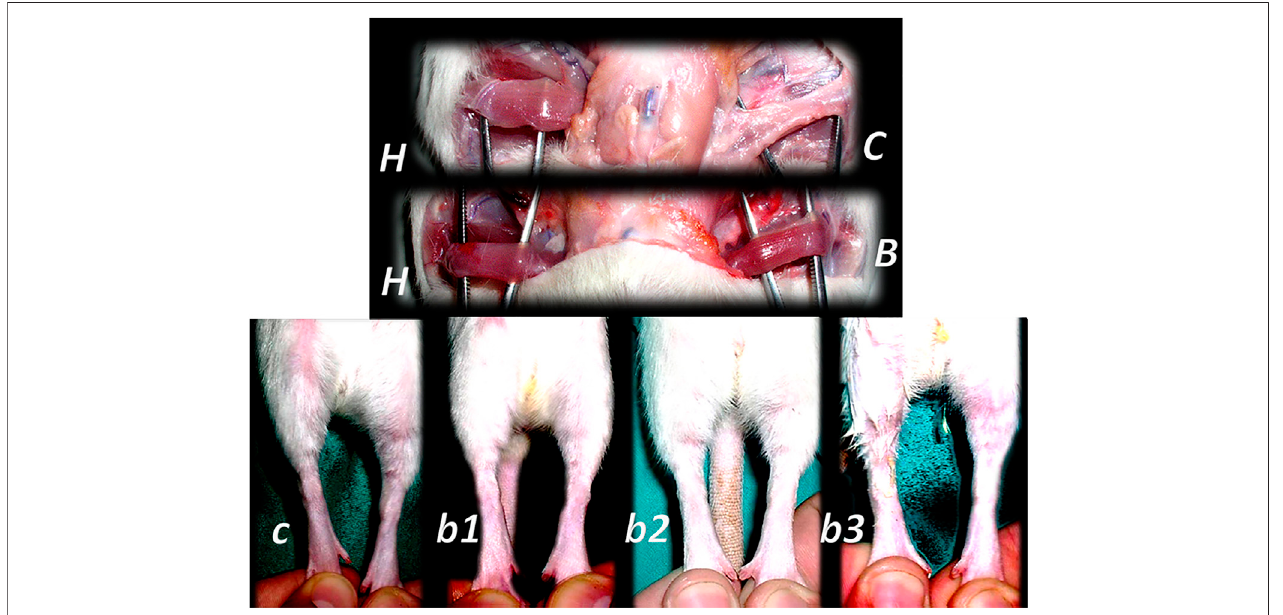
FIGURE11| Denervated gracilis muscleand BPC157therapy (upper) (Mihovilet al.,2009).Transected muscleinducedinjured leg function failure asinducedleg contracture and BPC 157 therapy (lower) (Staresinic et al., 2006). Presentation of the denervated gracilis muscle ( B, C ) and normal healthy gracilis muscle ( H ) in rats at 1 year after denervation. Characteristic denervated muscle presentation in controls ( C ). Counteraction by BPC 157 (10 μ g/kg) therapy given per-orally, in drinking water (0.16 μ g/ml, 12 ml/rat/day) till the sacri fi ce ( B ). Quadriceps muscle was completely transected transversely 1.0 cm proximal to patella to present a de fi nitive defect that cannot be compensated in rats with a considerable injured leg contracture as presented at postsurgery day 21 in controls with maximal leg extension ( c ). Counteraction by various regimens of the BPC 157 (10 μ g, 10 ng) therapy. Given intraperitoneally, once daily; the fi rst application 30 min posttransection, the fi nal 24 h before sacri fi ce ( b1 ); per-orally, in drinking water (0.16 μ g/ml, 0.16 ng/ml, and 12 ml/rat/day) till the sacri fi ce ( b2 ); locally, thin layer of neutral cream 1 µg/1 g neutral cream once daily; the fi rst application 30 min post-transection, the fi nal 24 h before sacri fi ce ( b3